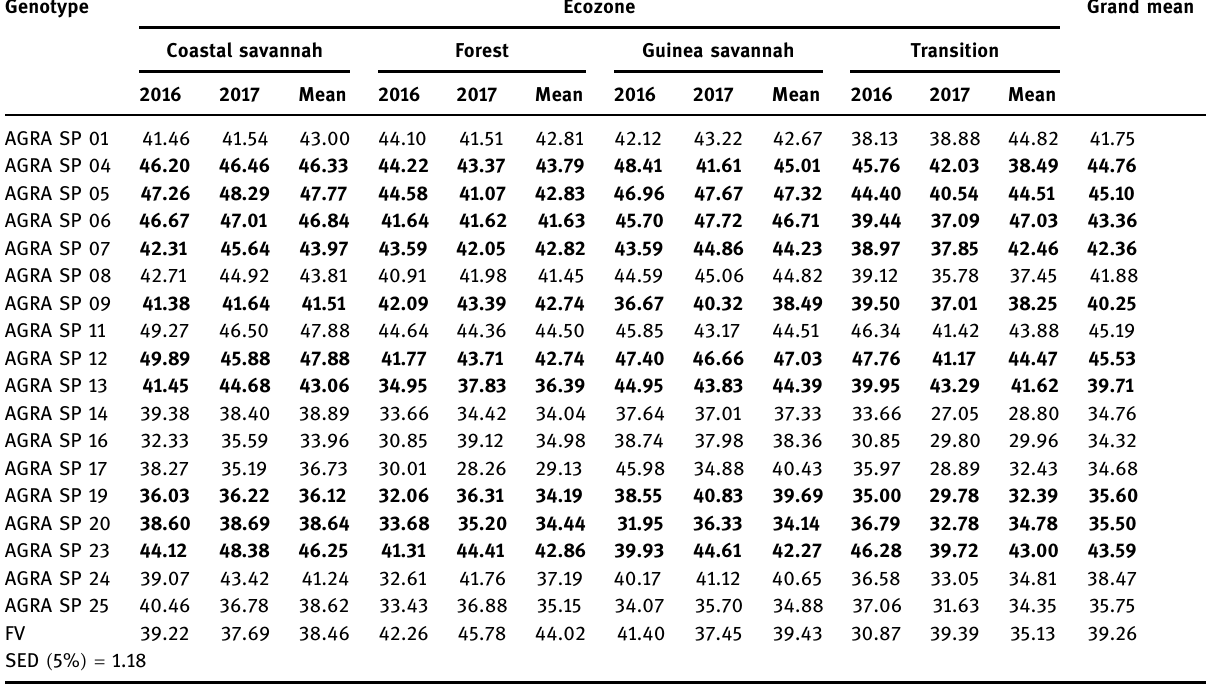
Table 5: Storage root dry matter content ( % ) of the sweetpotato genotypes across ecozones over two years Genotype